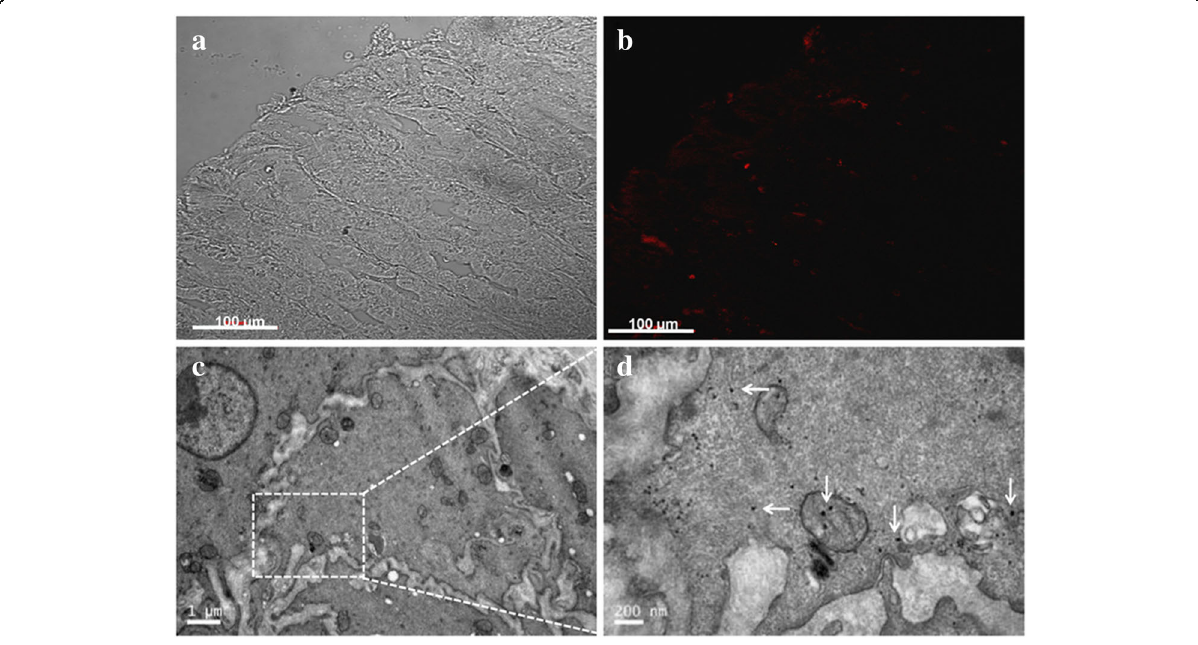
Fig. 9 Distribution of nanoparticles in the gastric tissue. ( a ) and ( b ): Two-photo-laser scanning confocal microscopy images of intestinal tissue sections 7 days after tail vein injection of GNRs (Excitation: 780 nm, Emission: 601-657 nm). ( c ) TEM image of the gastric parietal cells; ( d ) Triangular silver nanoplates located in the gastric parietal cells (white